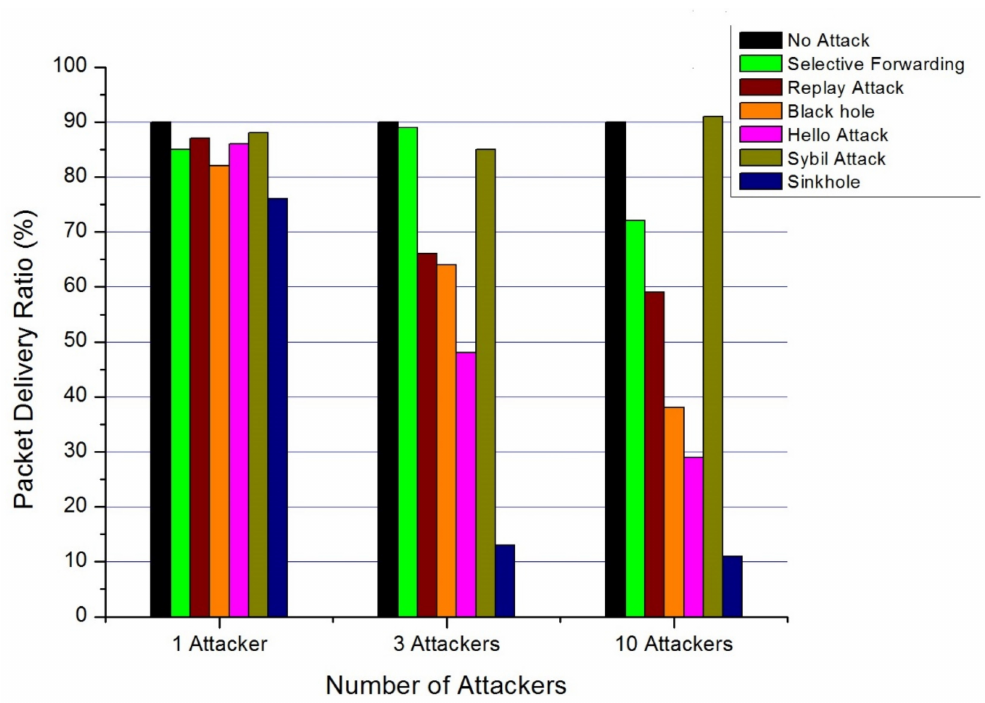
Figure 8. Packet delivery ratio vs. no. of attackers.